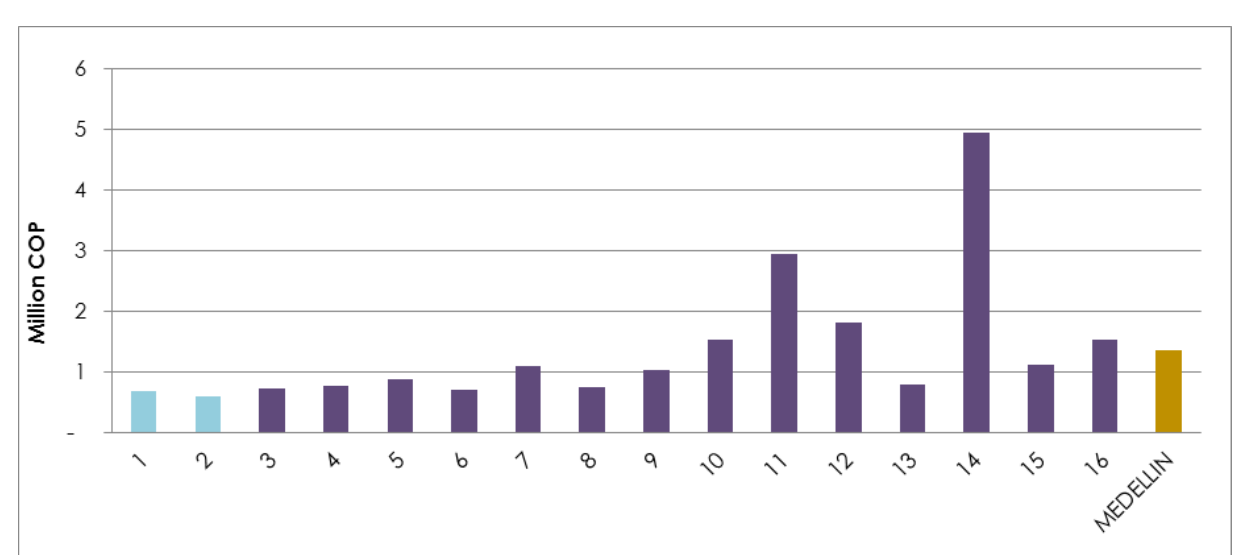
Figure 5. KSocial Scores per District 2011. Source: Hurtado et al. (2012).